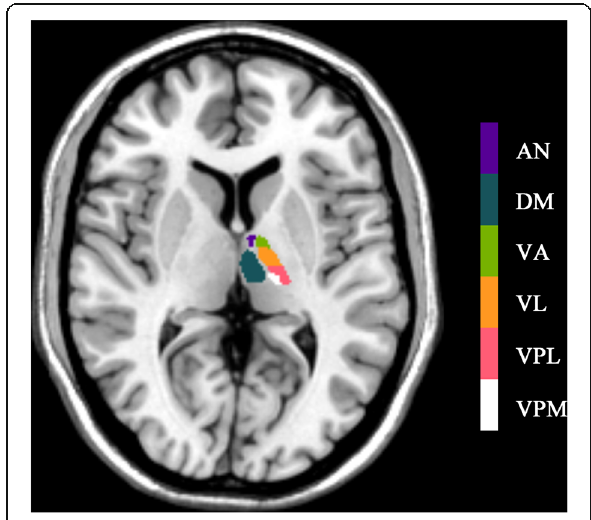
Fig. 1 The standard thalamic subnuclei templates were created according to Talairach template. AN, anterior nucleus; DM, doromedial nucleus; VA, ventral anterior nucleus; VL, ventral lateral nucleus; VPL, ventral posterior lateral nucleus; VPM, ventral posterior medial nucleus